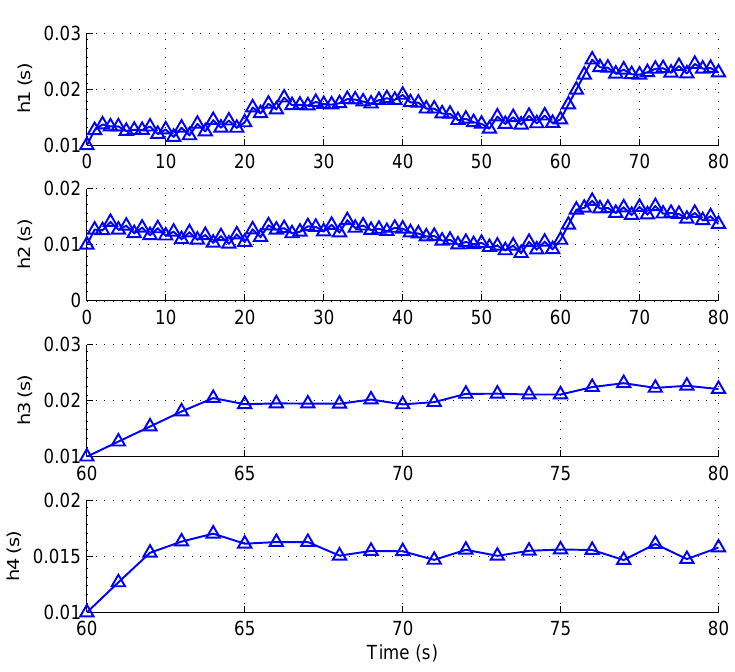
Figure 8. Sampling periods with